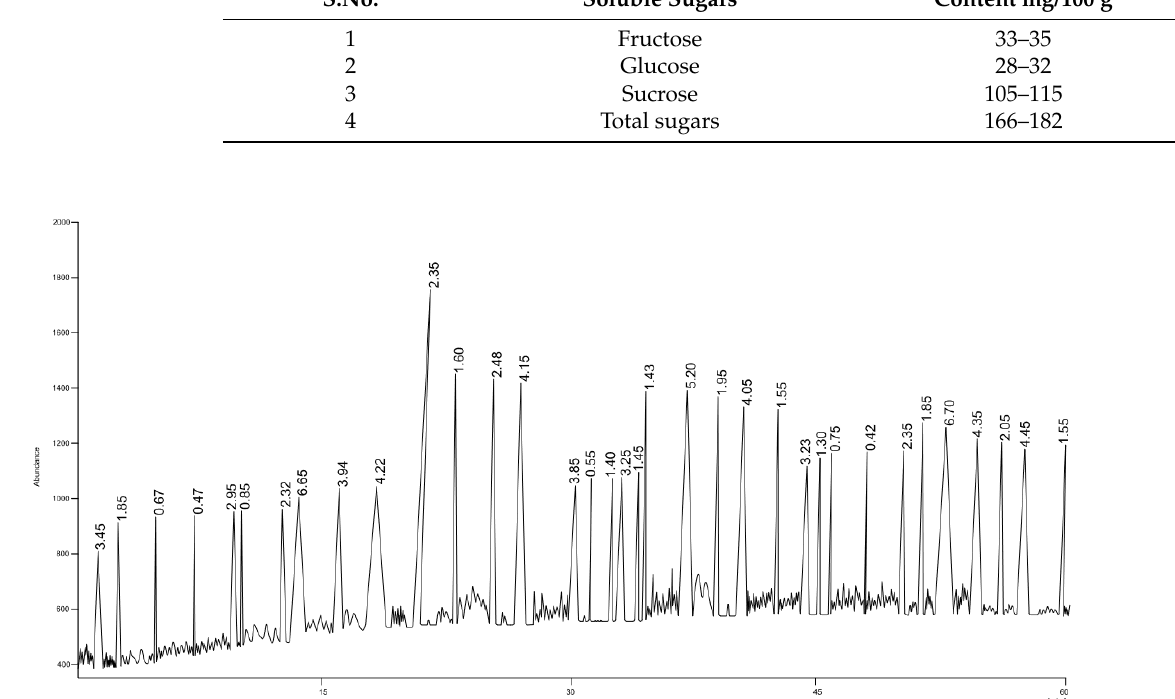
Figure 3. GC – MS chromatogram representing the bioactive constituents of aqueous extract of okra pods.